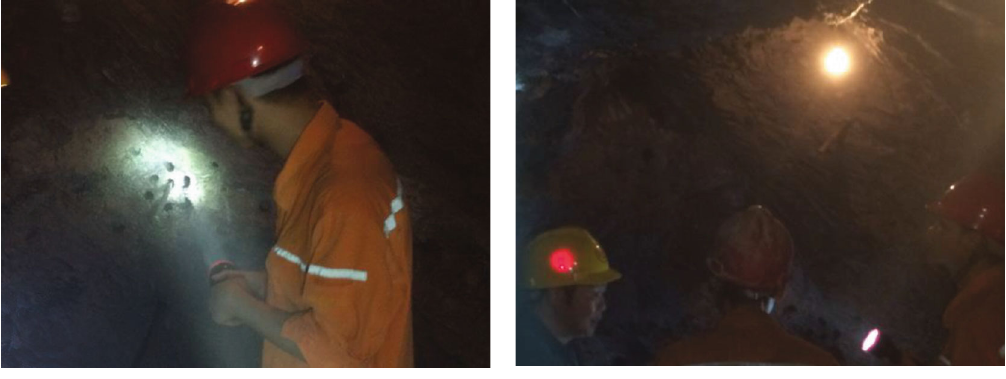
(a) Collection of blasting design parameters (b) Collection of blasting result parameters Figure 10: Collection of engineering site parameters.